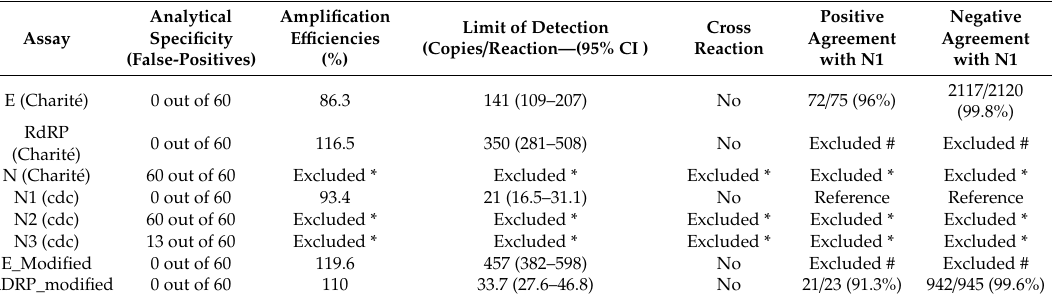
Table 5. Performance characteristics of two RT-qPCR protocols for SARS-CoV-2 detection performed in an automated